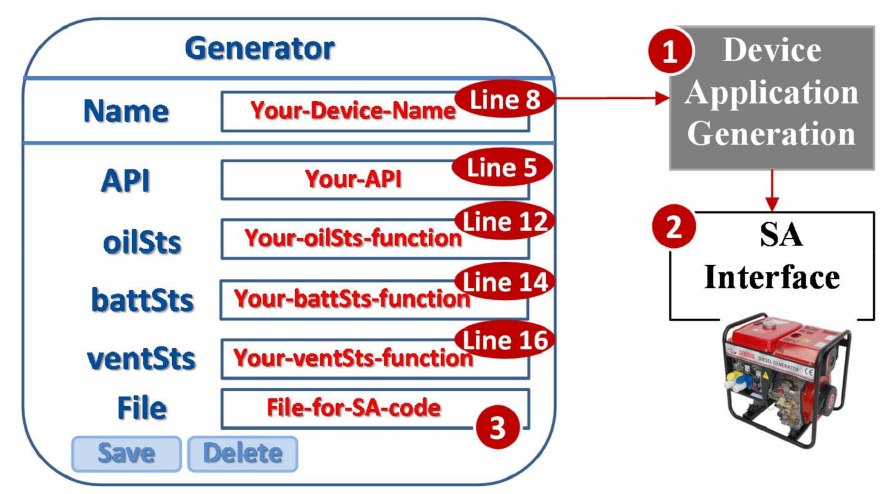
Figure 8. Binding the DUT and SpecTalk by creating the SA interface of